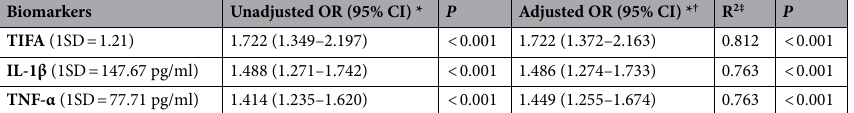
Table 3. Logistic regression analysis for the predictors of pulmonary arterial hypertension in the study population (n = 99). IL-1β, interleukin-1β; TIFA, tumor necrosis factor-α receptor-associated factor-interacting protein with a forkhead-associated domain; TNF-α, tumor necrosis factor-α. *Odds ratio (OR) and 95% confidence interval (CI) per-0.1 standard deviation (SD) were presented. † Adjusted for age. ‡ R 2 denotes Nagelkerke pseudo R-squared